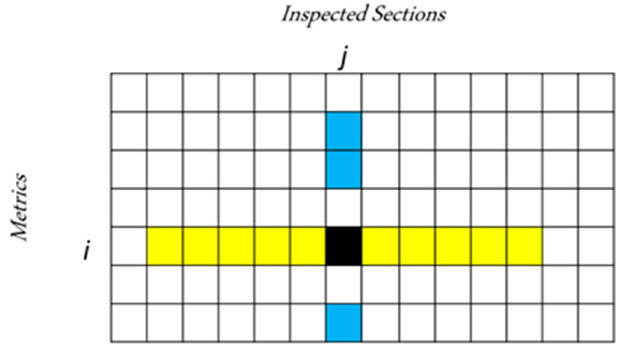
Figure 13. Measurements involved in the estimation of the i-th metric at the n-th inspected section (black square): measurements relative to correlated metrics at the same inspected section (light blue squares), and measurements of the same metric averaged over spatially adjacent sections (yellow squares).